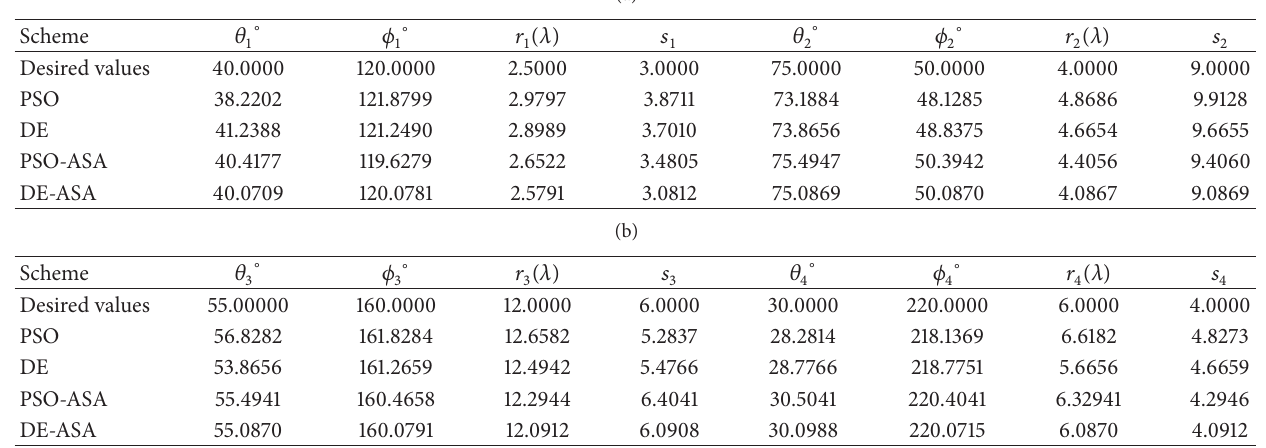
Table 4: Estimation accuracy for 4 targets.